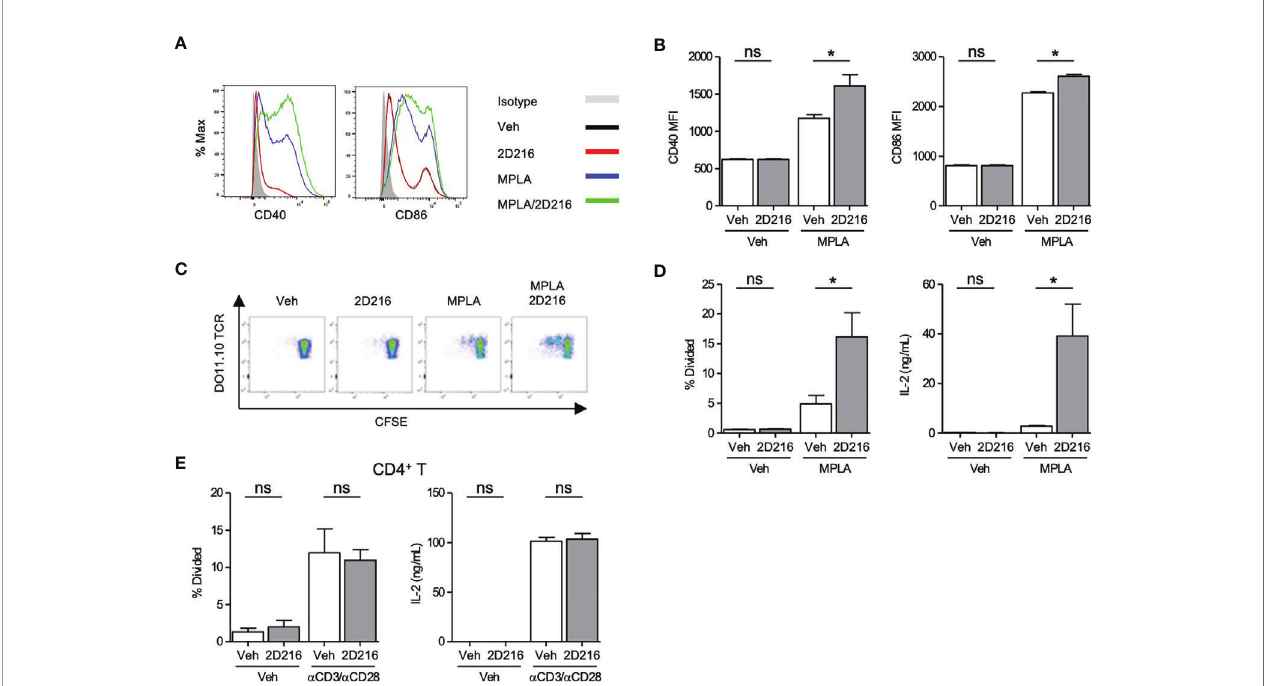
FIGURE 2 | 2D216 enhances MPLA-induced antigen presenting function in mBMDCs. (A, B) Co-stimulatory molecule expression induced by 2D216 . mBMDCs (1×10 6 cells/mL) were incubated with vehicle (Veh), 2D216 (5 m M), MPLA (100 ng/mL), or 2D216 (5 m M) plus MPLA (100 ng/mL) for 24 h and expression of CD40 and CD86 were compared by mean fl uorescent intensity (MFI) analyzed using fl ow cytometry, *p < 0.05 by Mann-Whitney U test compared to Veh/Veh or MPLA/Veh. (C) Representative plots of T cell proliferation with MPLA/ 2D216 treated mBMDCs in co-culture. mBMDCs (0.5×10 6 cells/mL) were treated with Veh, 2D216 (5 m M), MPLA (100 ng/mL), or MPLA (100 ng/mL)/ 2D216 (5 m M) overnight, and pulsed with OVA (10 m g/mL) for 4 h. Antigen-pulsed mBMDCs were then co-cultured with the same number of CFSE-labelled CD4 + DO11.10 T cells for 3 days. (D) T cell proliferation was determined by CFSE dilution. Percent T cells that divided relative to the original population is shown. IL-2 released in the culture supernatant was determined by ELISA. (E) Primary mouse splenic CD4 + T cells were isolated, CFSE-labeled and stimulated with plate-bound anti-CD3 antibodies (0.5 m g/mL) and soluble anti-CD28 antibodies (1 m g/mL) with or without 2D216 (5 m M) for 3 days. T cell proliferation was determined by CFSE dilution. IL-2 levels in the culture supernatant were measured by ELISA. Data represent mean ± SD of triplicates of two independent experiments showing similar results. *p < 0.05 by Mann-Whitney U test compared to Veh/Veh or MPLA/Veh. ns, not signi fi